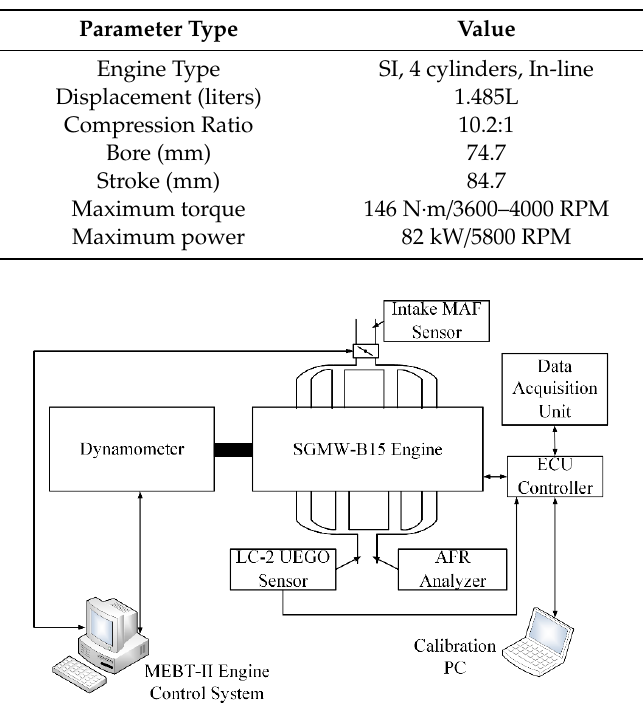
Table 1. SGMW B15 Engine Specifications.